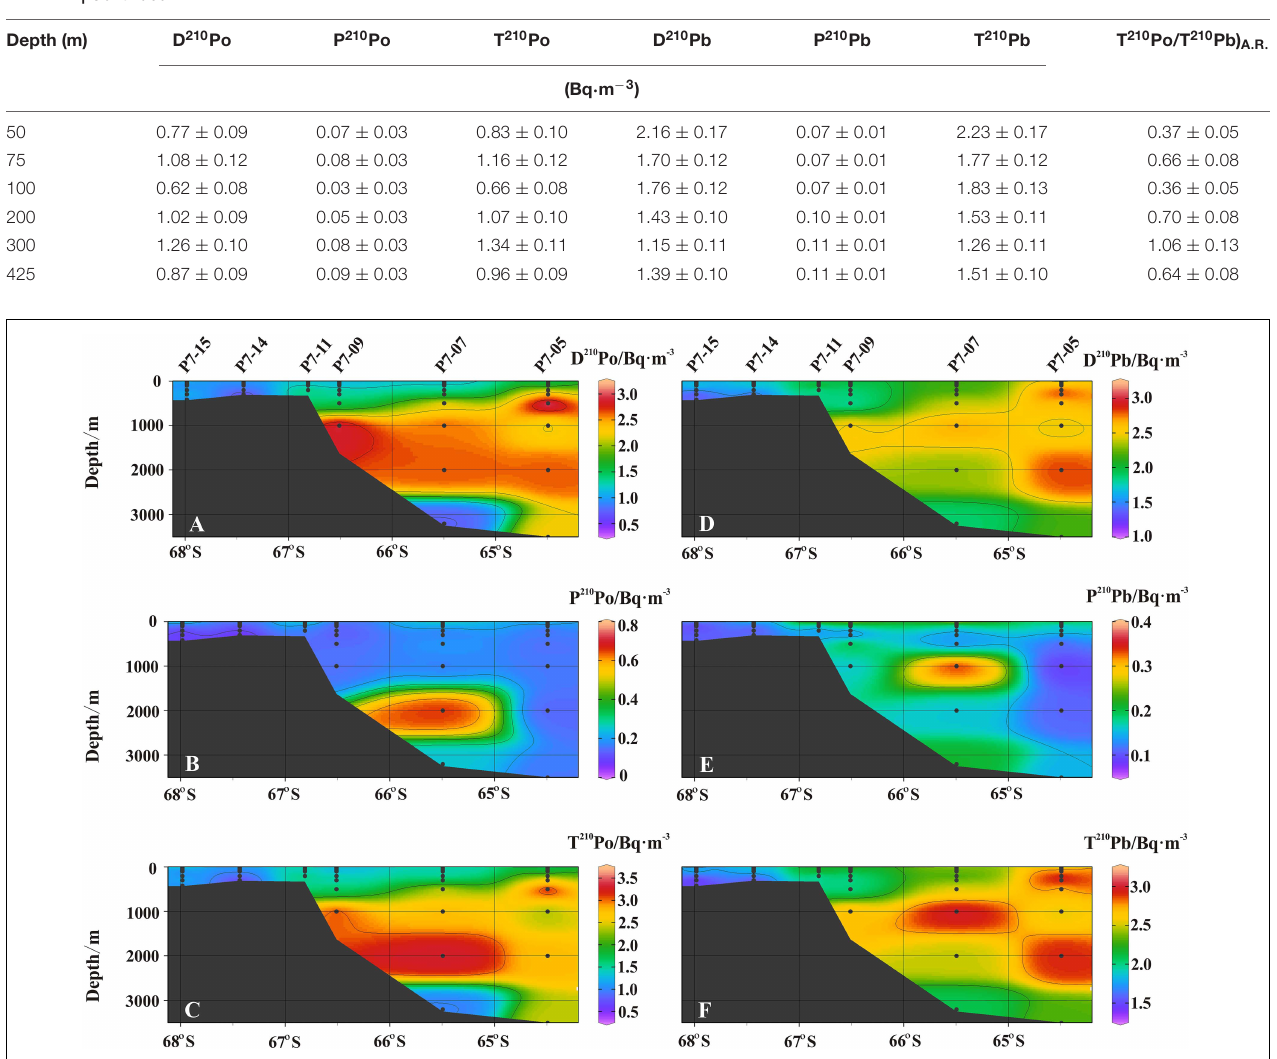
FIGURE 3 | The sectional distribution of (A) dissolved 210 Po (Bq/m 3 ), (B) particulate 210 Po (Bq · m − 3 ), (C) total 210 Po (Bq · m − 3 ), (D) dissolved 210 Pb (Bq · m − 3 ), (E) particulate 210 Pb (Bq · m − 3 ), and (F) total 210 Pb (Bq · m − 3